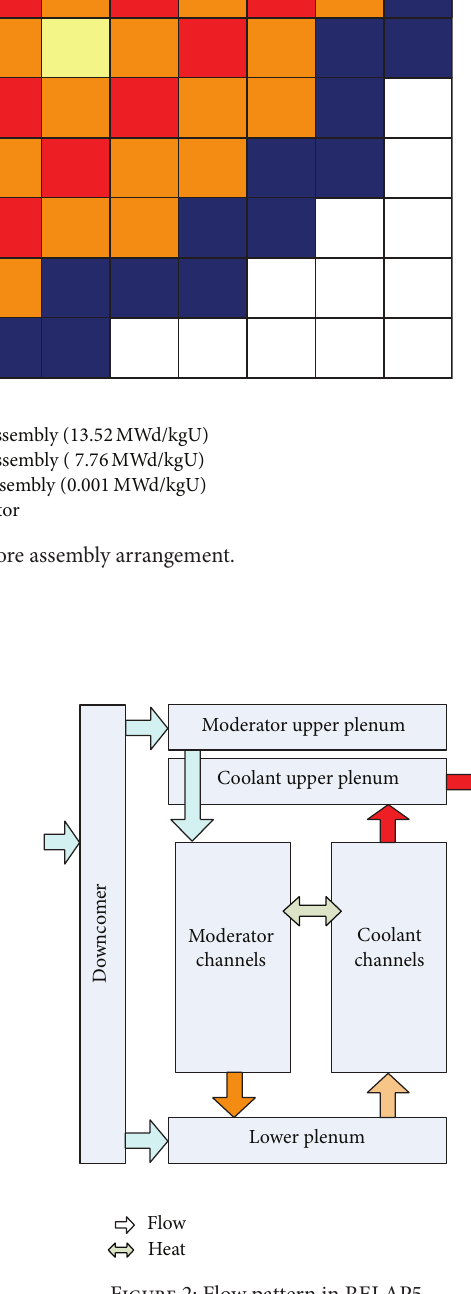
Figure 2: Flow pattern in